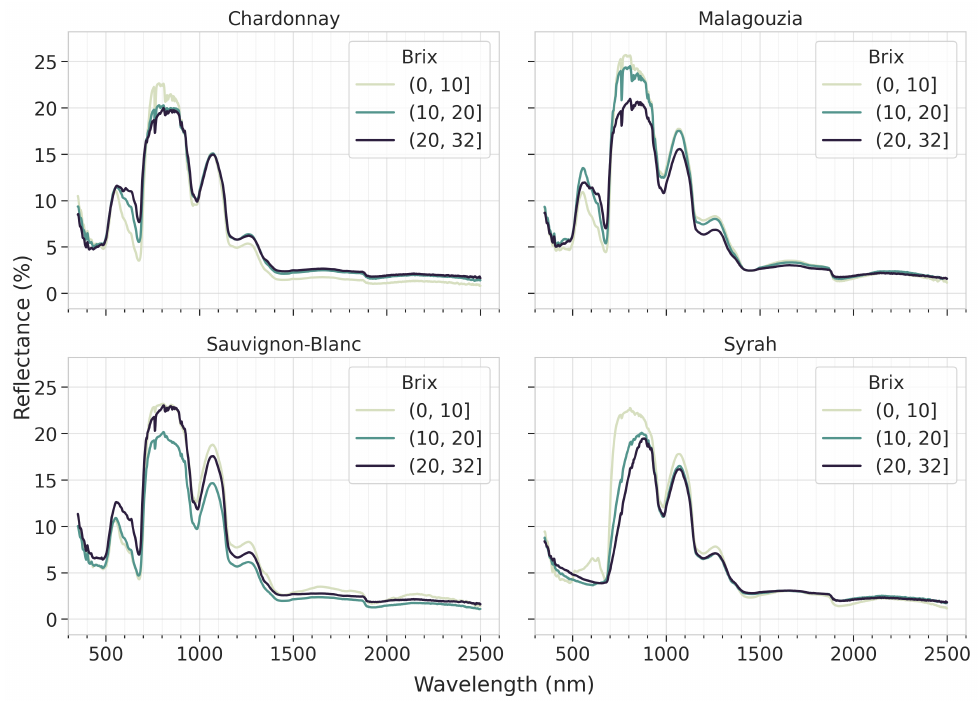
Figure 7. The effect of the change the °Brix content (grouped into three arbitrary classes) has on the mean reflectance spectra of each grape variety.